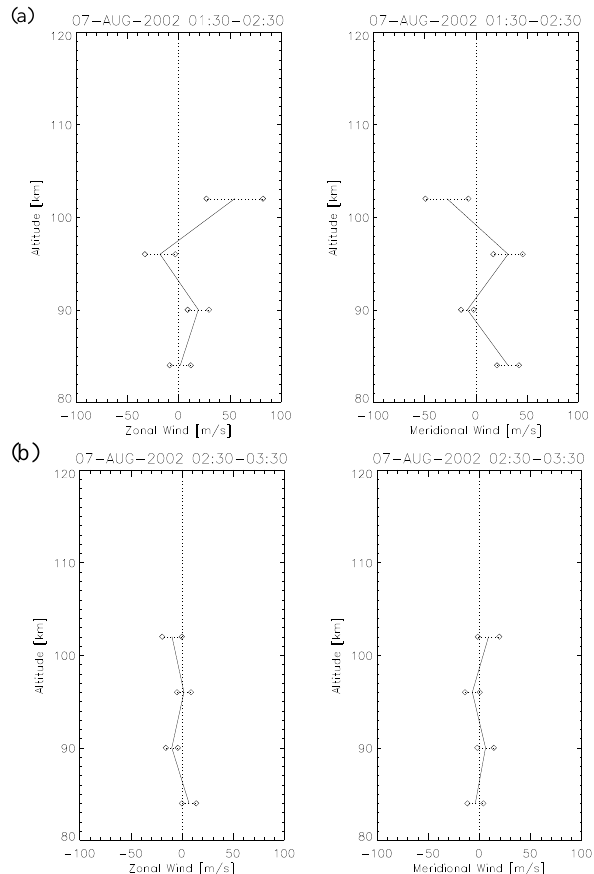
Fig. 11. Zonal (Eastward) and Meridional (Northward) components of neutral wind velocity (a) from 0130 to 0230 JST and (b) from 0230 to 0330 JST, 7 August 2002 are